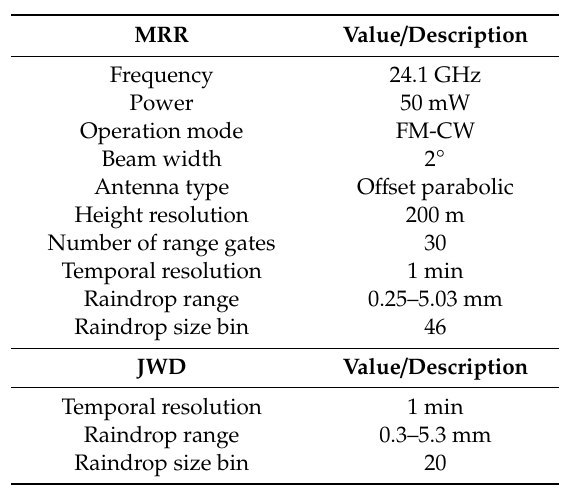
Figure 1. Location of Tokyo (raindrop size distribution (RSD) measured site), location of Tateno (radiosonde sounding station) and tropical cyclone (TC) paths (gray filled circles denote typhoons, and white open circles denote tropical storms; the sea pressure level and wind speed of the nearest TC center to Tokyo were marked in “1”–“4” and listed in the legend). Table 1. Characteristics of the micro rain radar (MRR) and Joss-Waldvogel disdrometer (JWD) used in this